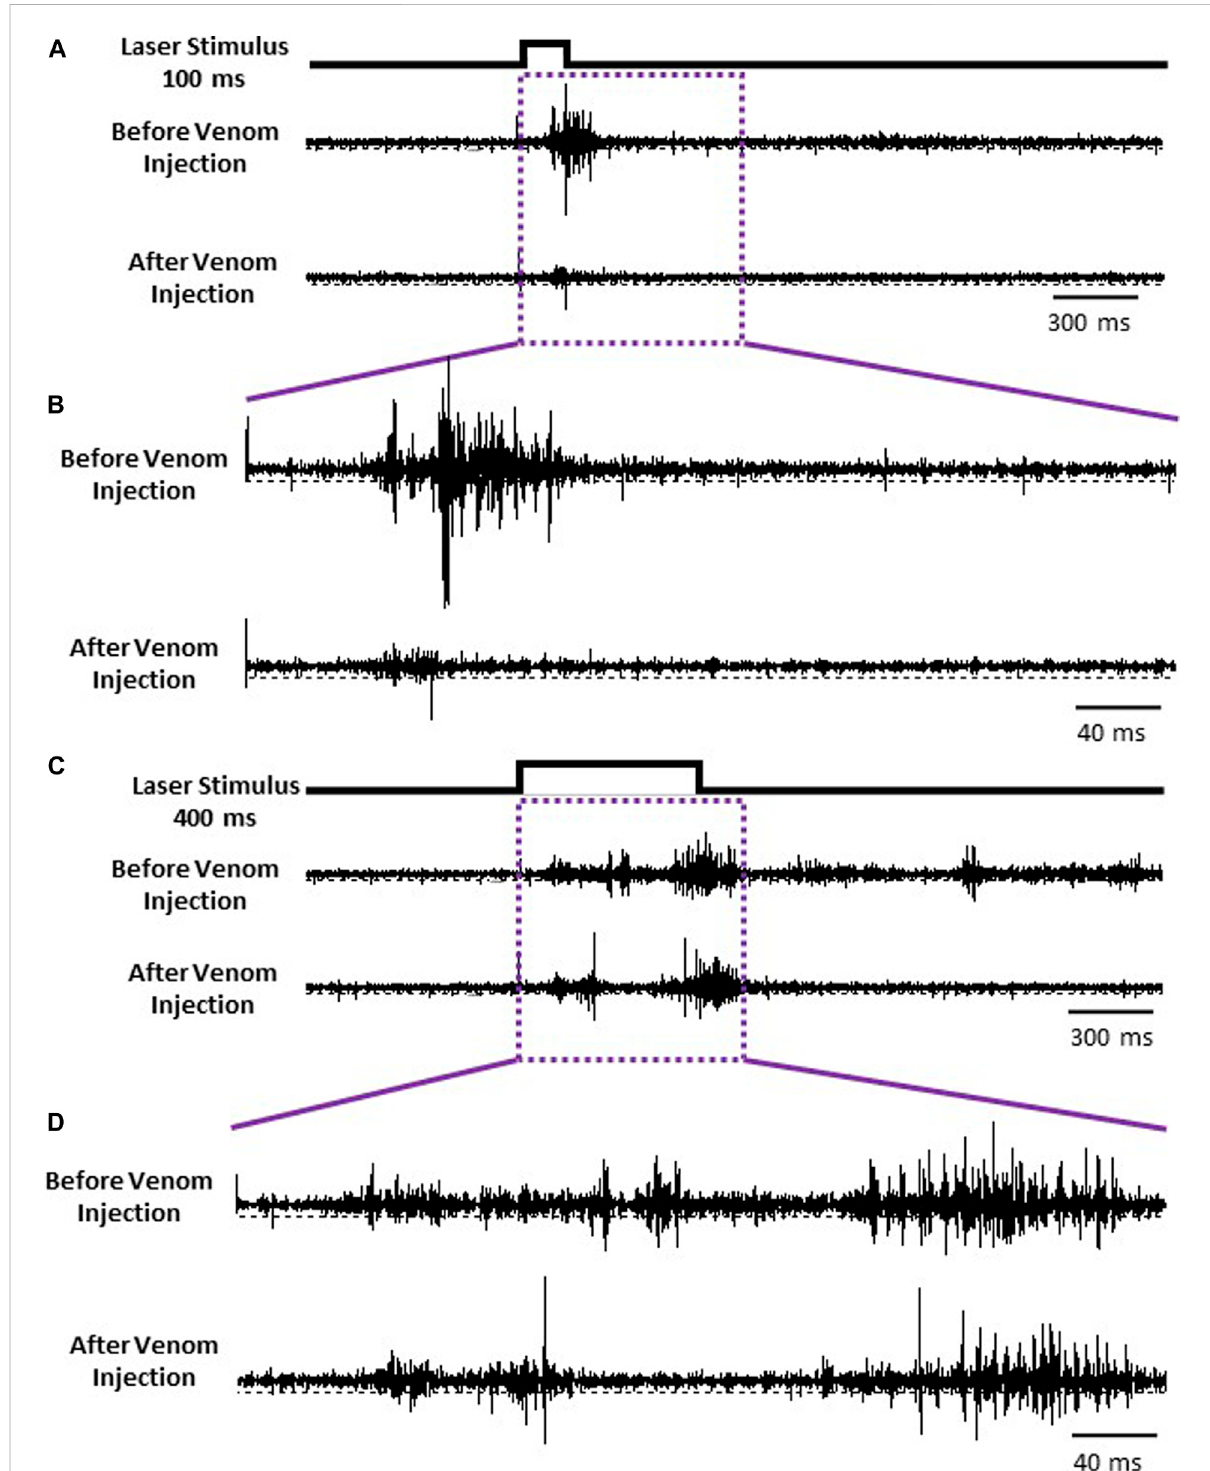
CXisthe fi nalcenterforprocessingnociceptiveinput. (A) RepresentativeexamplesrecordingsofCXforineffective100 mslaserstimulusbefore (Upper trace) and after the venom injection (Lower trace). (B) Enlarged view of traces in purple box in panel (A) . (C) Representative examples recordings of CX for an effective 400 ms laser stimulus before and after the venom injection. (D) Enlarged view of traces in purple box in panel (C)